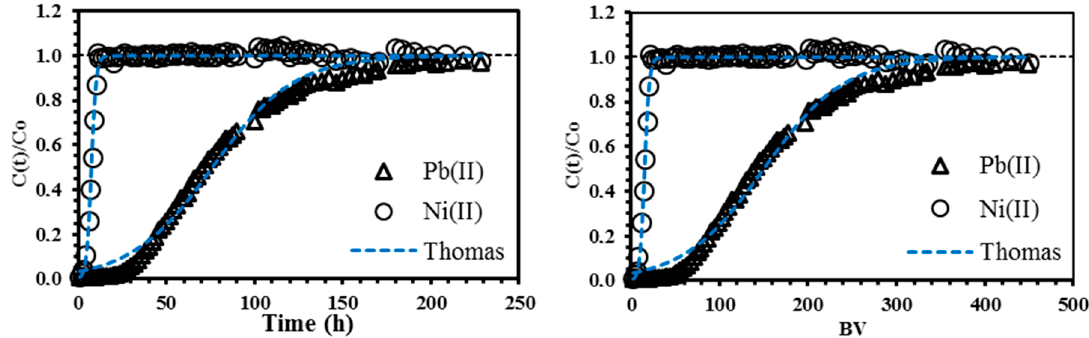
Figure 6. Breakthrough curves for a binary system of Pb(II) and Ni(II) using hydrated CAM-D2EHPA as sorbent (dashed line: Thomas model; T : 20 ◦ C; internal diameter of the column, Ø: 0.5 cm; column height: 20 cm; flow rate: 0.13 mL min − 1 ; pH: 2.2; C 0 : 0.24 mmol L − 1 ).